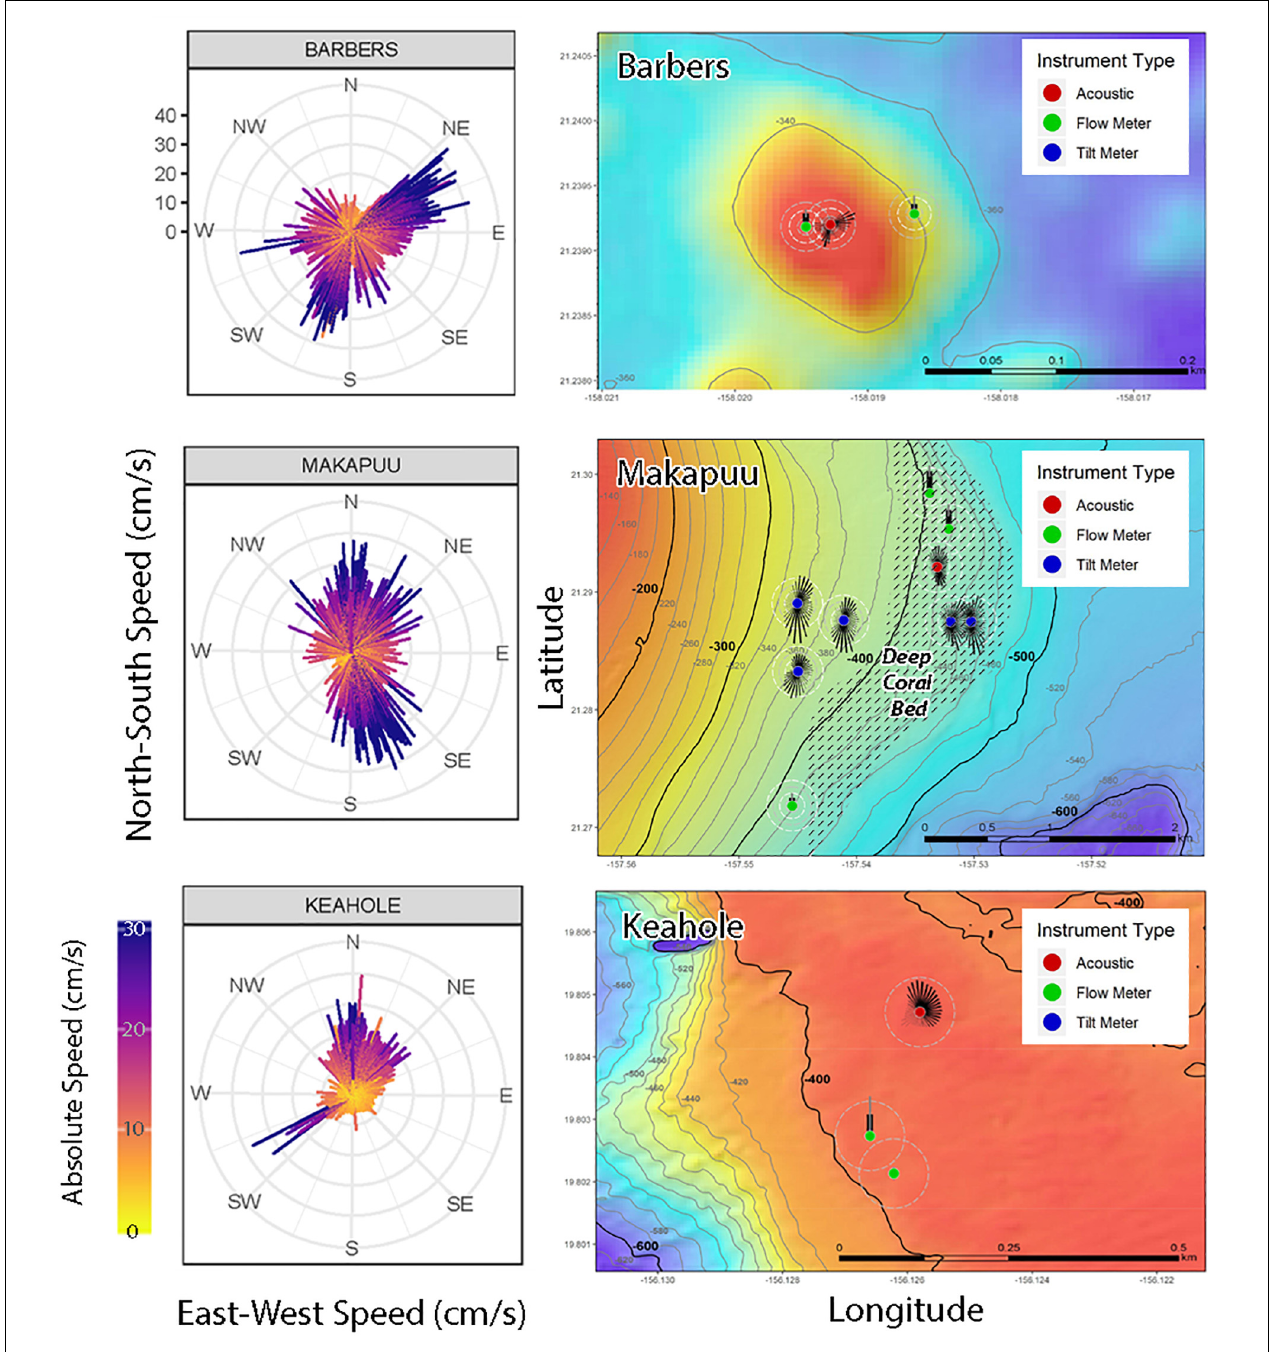
FIGURE 3 | Plots of the dominant direction of current flow at the three coral patches. The left column shows the flow rose from the acoustic current meter placed at the center of each patch. The right column has maps of the patch topography with flow roses for all the instruments placed to show the within-patch flow gradient. Red dot is the acoustic current meter, blue dots are tiltmeters, and green dots are flowmeters. As the flowmeters only record flow intensity, a single vector representing mean intensity was set to point north, similar to the instruments that recorded direction. Dash shading on the Makapu‘u Pt. patch map indicates